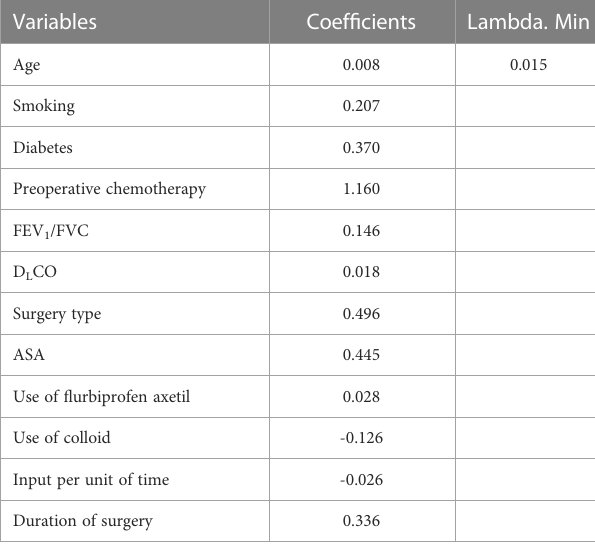
TABLE 2 Coef fi cients of the LASSO